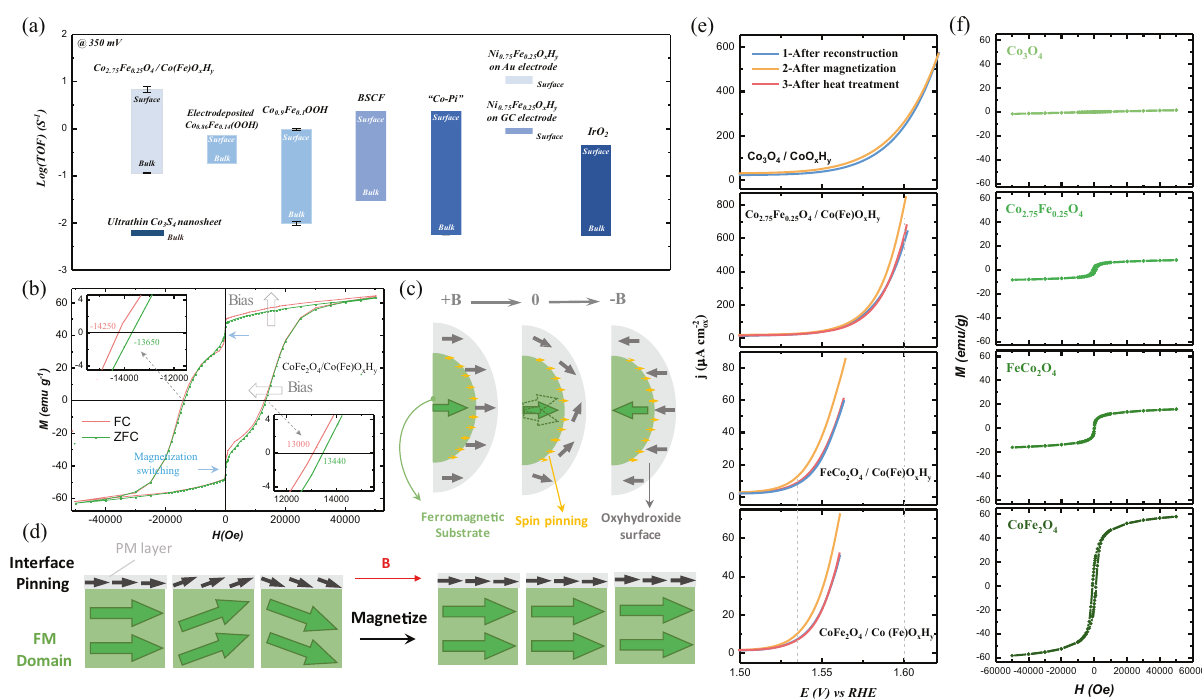
Fig. 2 OER enhancement by spin pinning in Co 3 − x Fe x O 4 /Co(Fe)O x H y under magnetic fi eld. a Turnover frequency (TOF) values of reconstructed Co 2.75 Fe 0.25 O 4 (s) (i.e., Co 2.75 Fe 0.25 O 4 /Co(Fe)O x H y ), electrodeposited Co 0.86 Fe 0.14 (OOH) 17 , Co 0.9 Fe 0.1 OOH, Ba 0.5 Sr 0.5 Co 0.8 Fe 0.2 O 3 − δ (BSCF) fi lm 64,65 , electrodeposited cobalt hydroxide (Co-Pi) 65,66 , Ni 0.75 Fe 0.25 O x H y NPs on Au electrode 53 , electrodeposited Ni 0.75 Fe 0.25 O x H y on glassy carbon (GC) electrode 54 , IrO 2 (in acid) 55 , and ultrathin Co 3 S 4 nanosheet 67 . The TOF bulk and TOF surface of some catalysts present the lower and upper limits of